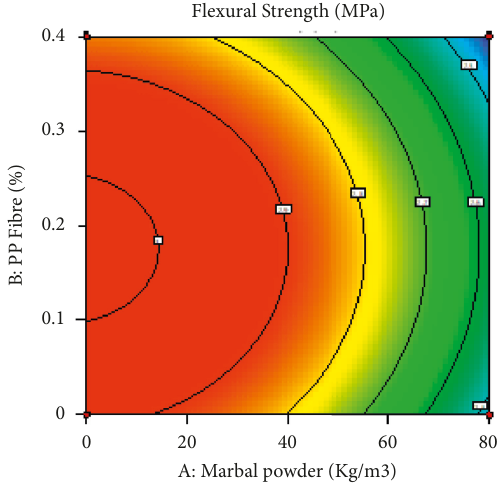
Figure 11: 2D contour plot for flexural